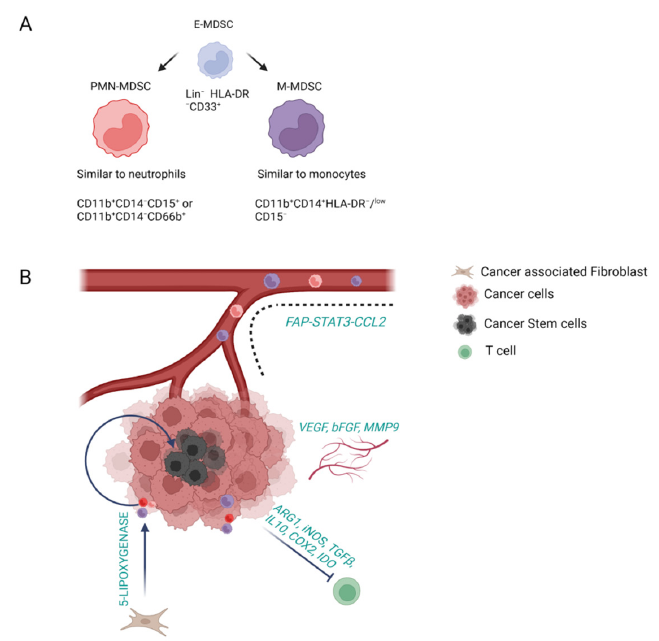
Figure 3. Classification, recruitment and functional activity of myeloid-derived suppressor cells (MDSC). ( A ) Subclassification of MDSC. MDSC are subgrouped into granulocitic (PMN-MDSC), representing the 80% of total MDSC, and monocytic (M-MDSC). ( B ) Recruitment and functional activity of MDSC. MDSC are recruited into CCA tissue mainly through the FAP–STAT3–CCL2 pathway and they cover their protumoral activity mainly by inhibiting T cells, by affecting angiogenesis and by sustaining the cancer stem cell niche.